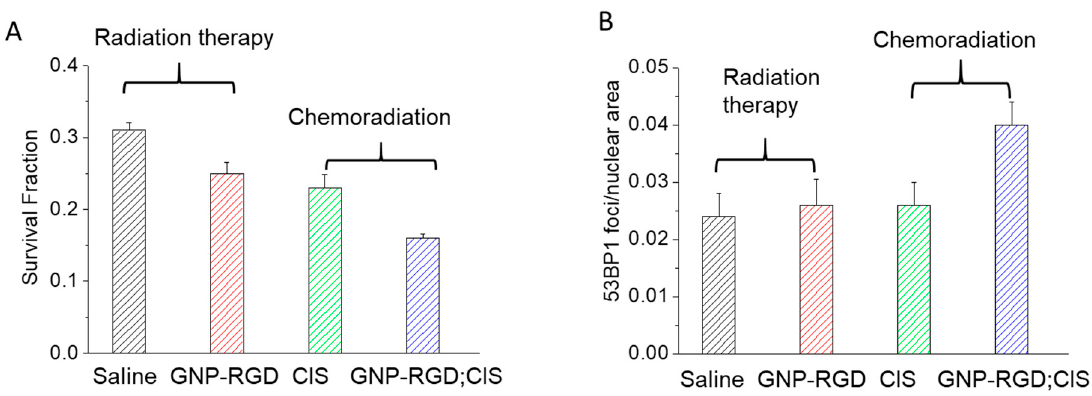
Figure 7. GNP-mediated radiation therapy vs. chemoradiation. ( A , B ) Clonogenic and DNA DSBs assay results showing how the presence of GNPs affect the treatment outcome.